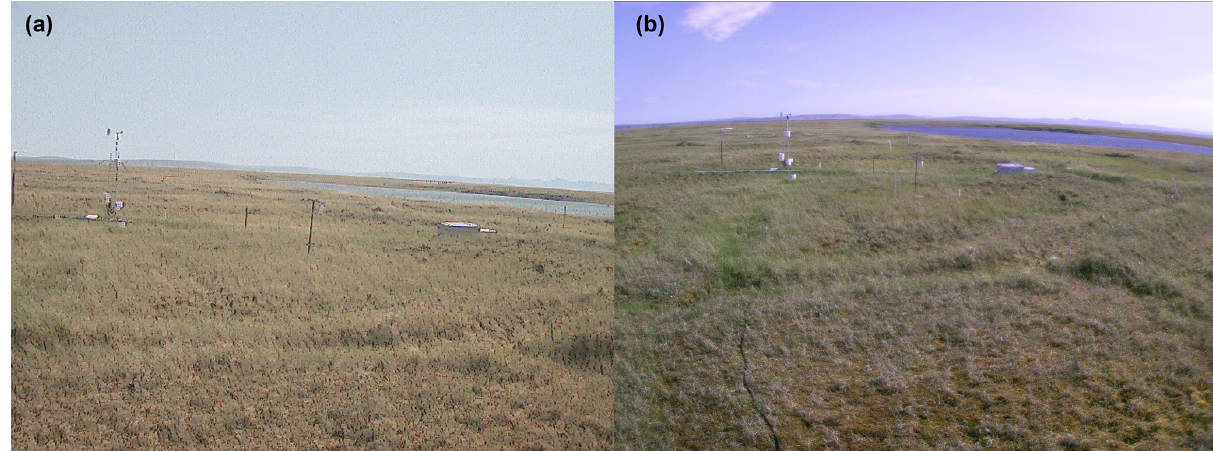
Figure B6. Examples of photos taken by the cameras used for time-lapse photography (Fig. B5) showing summer field conditions. (a) Left photo taken by the Campbell Scientific CC640 camera (at a height of 2.2m) and (b) right photo taken by the Campbell Scientific CC5MPX camera (at a height of 3m) on 7 August